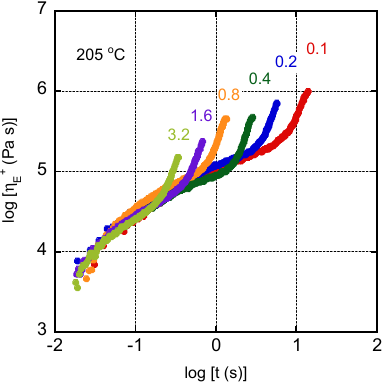
+ of CA/TEC (60/40) at 205 °C. The numerals